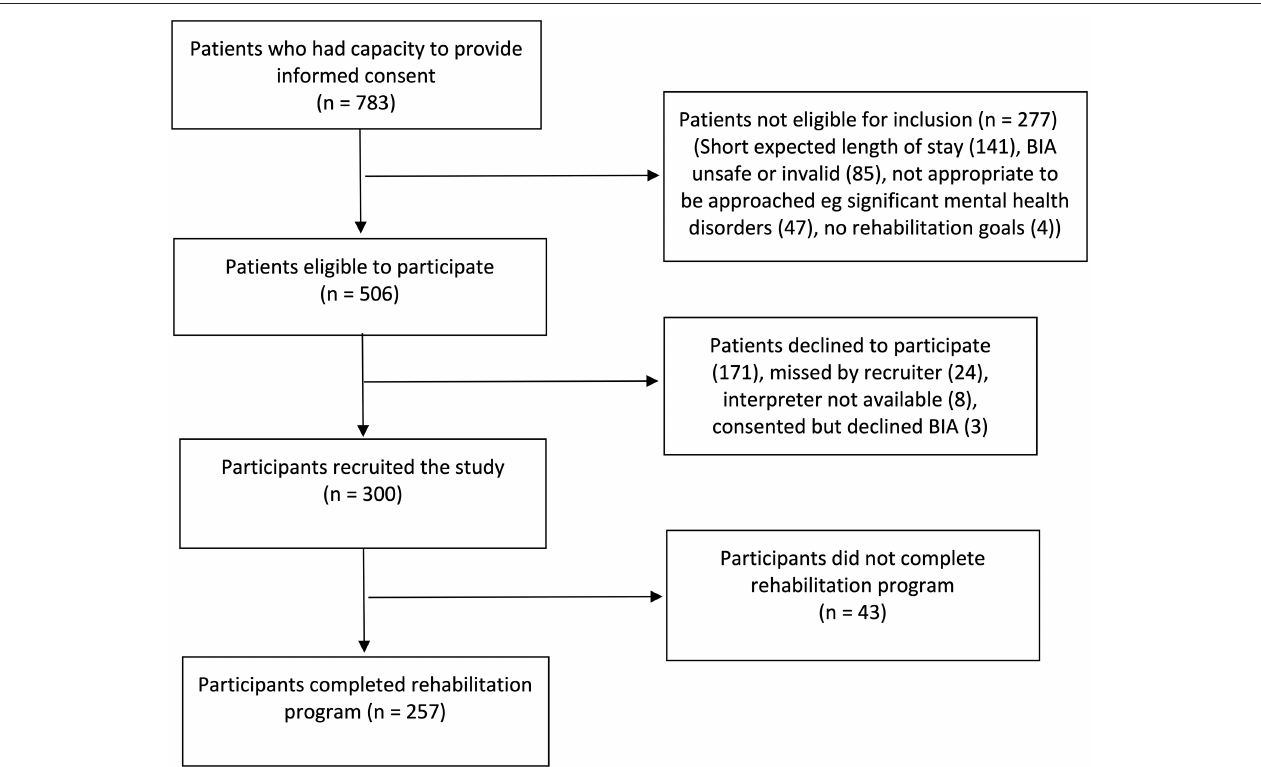
FIGURE 1 | Study recruitment flow chart (BIA, BioImpedance